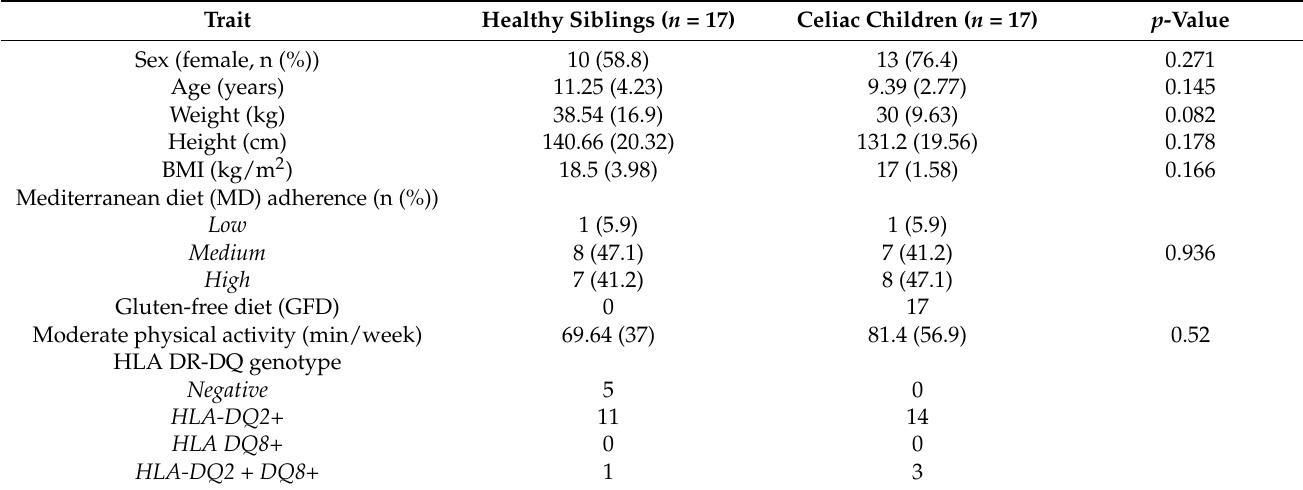
Table 1. Demographic and biological characteristics of the study